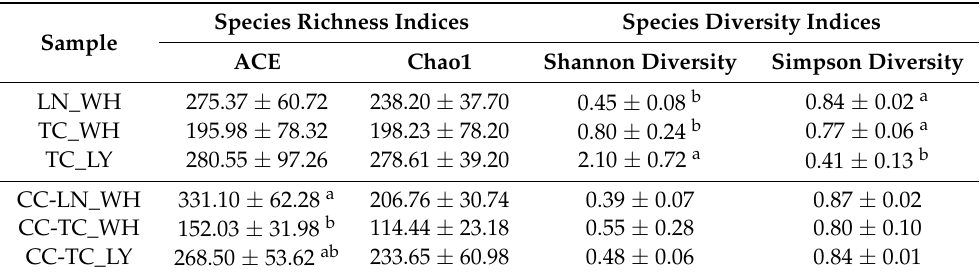
Table 1. Richness and diversity estimation (mean ± SEM) of the bacterial community in the gut of six groups.